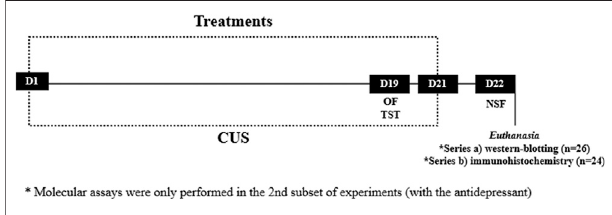
FIGURE 1 | Timeline of our experimental designs. On the 19 th day of Chronic Unpredictable Stress (CUS) and treatment, mice were submitted to Open Field (OF) and Tail Suspension Test (TST). 24 h following the CUS protocol, mice were submitted to Novelty Supressed Feeding (NSF). After the d of the protocol, brains were processed for WB and